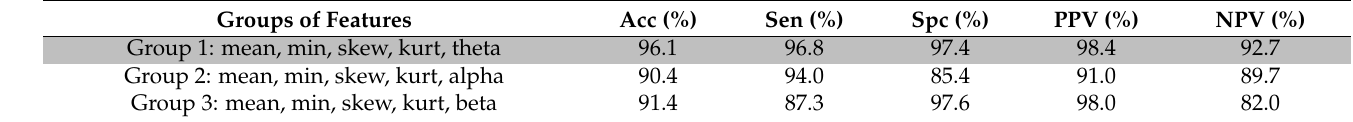
Table 2. The performance of the network in distinguishing normal subjects from epileptic subjects in the training stage.